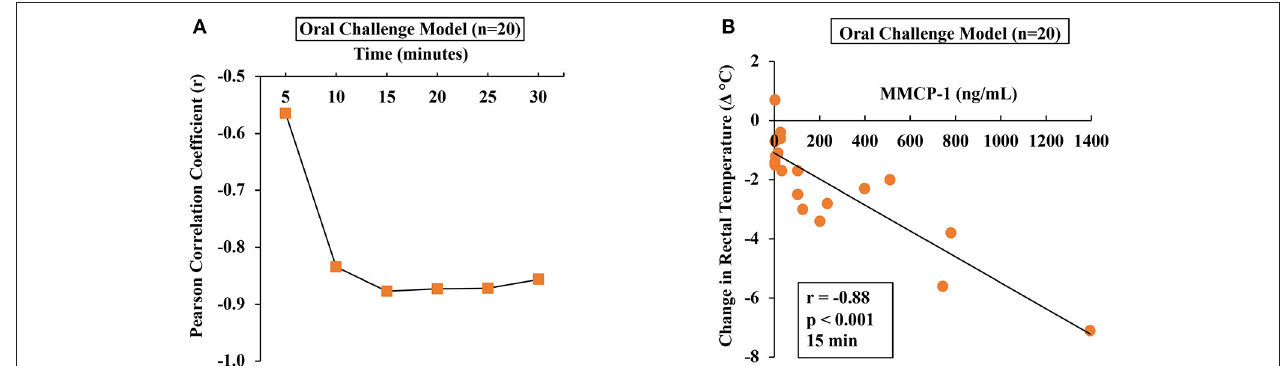
FIGURE 5 | Hypothermic shock responses in durum wheat (AABB genome) SSPE-allergic mice correlated with their degranulation of mucosal mast cells. Mice received treatments as described in Materials and Methods. Their serum MMCP-1 levels (ng/ml) were compared with change in rectal temperature ( 1 ◦ C) post-challenge using Pearson correlation analysis. (A) Pearson correlation coefficient ( r ) at indicated time points in orally challenged allergic mice with SSPE (20mg). (B) Pearson correlation analysis at 15min post-challenge in saline-challenged control mice ( n = 10) and SSPE-challenged (20mg) allergic mice ( n = 10) via the oral route. MMCP-1, mucosal mast cell